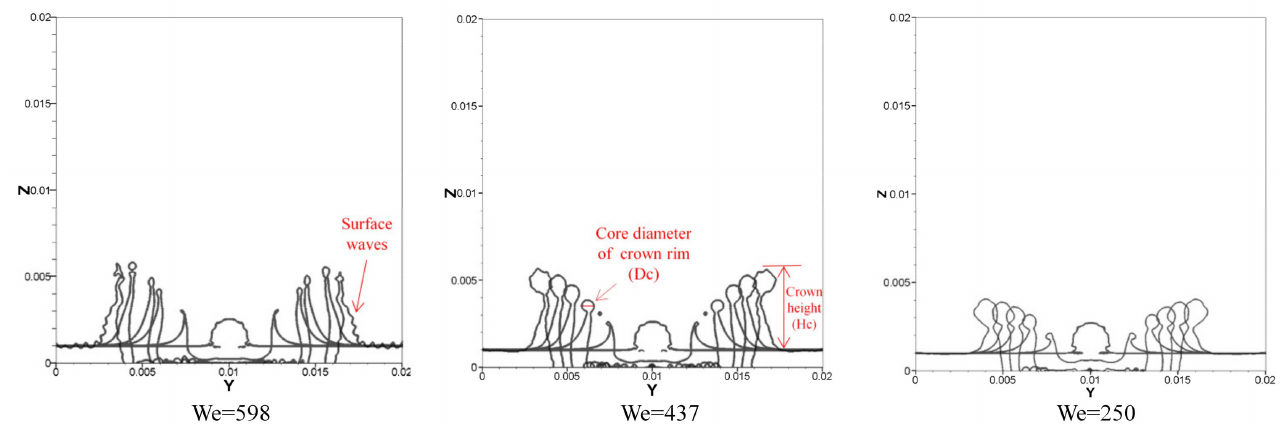
Figure 6. The evolution of x = 0.01 m section of the crown at different